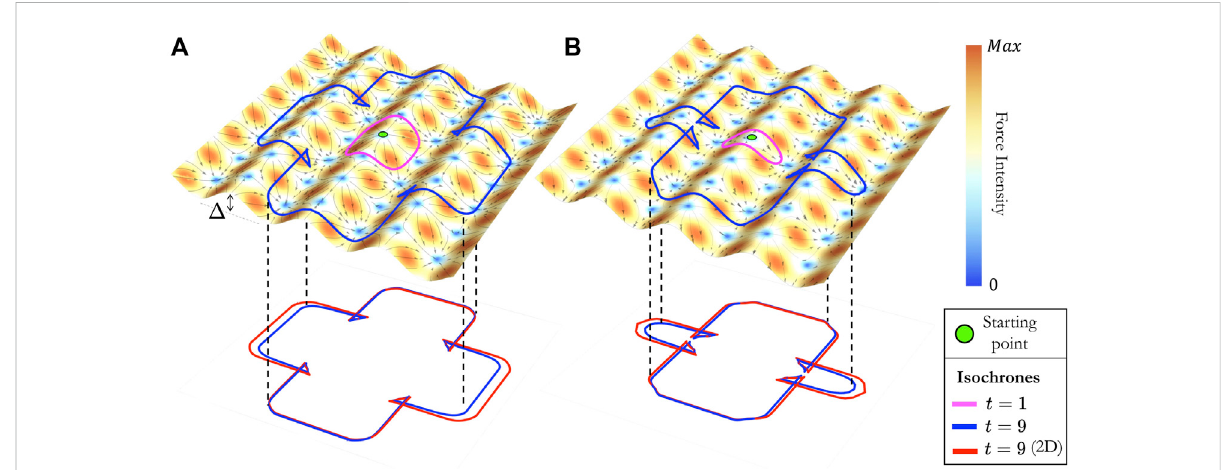
FIGURE 5 Schematicrepresentation ofthewavysurfaceusedto study theeffect ofspacecurvatureontheactive particle navigation inthesamepotential landscape de fi ned by Eq. 2. Two short-time RP isochrones ( t = 1 and t = 9 corresponding to the magenta and blue curves, respectively) are shown here for two different starting points (green dots): (A) maximum and (B) saddle point. The relative force strength here is fi xed at γ = 0.79, while the wave amplitude is set to Δ = 0.5. The most immediate effect of space curvature is to break the force fi eld spatial symmetry. This is apparent by comparingthe2Dprojectionoftheisochroneonthesurfacewithitscounterpartobtainedfromtheplanarsimulations( Δ =0,redcurve).Theformer is indeed clearly shorter along the direction of the wave. In both panels, the color gradient shows the intensity of the external force fi eld, while the gray arrows indicate its